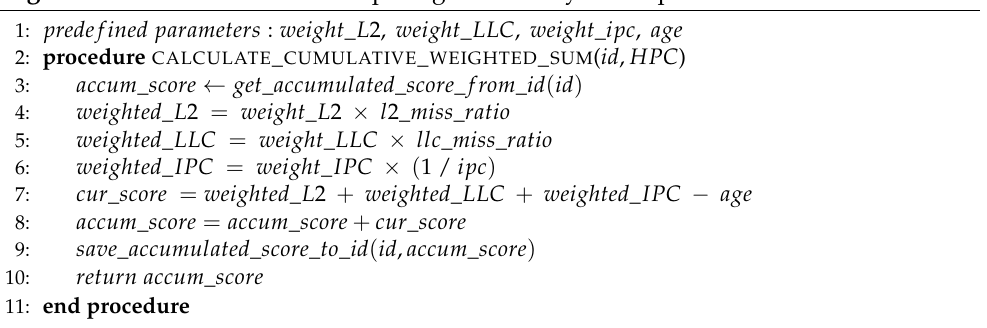
Algorithm 1 Pseudo-code of Computing CUSUM by RT-Sniper